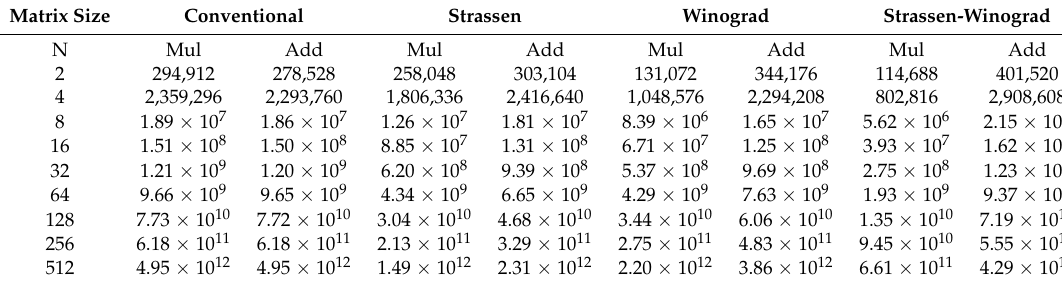
Table 1. Computational complexity of different